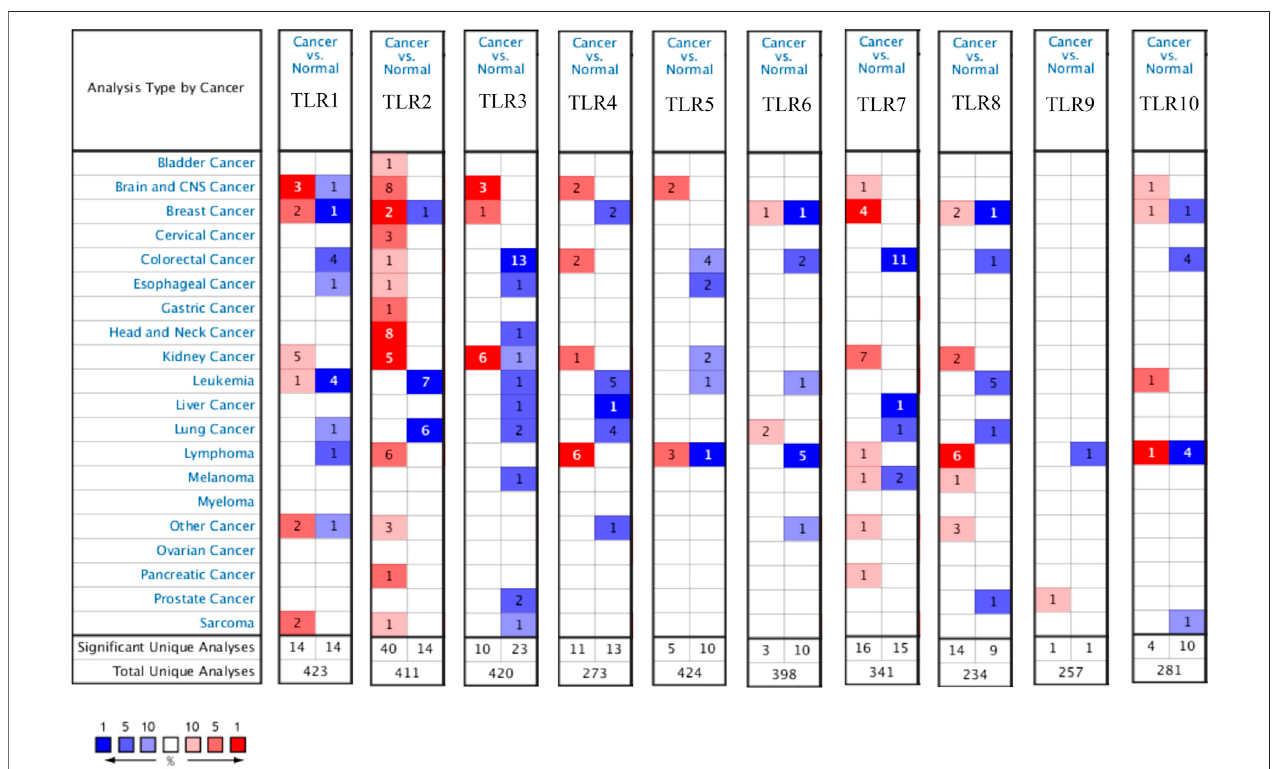
FIGURE 1 | Expression levels of TLRs in kidney cancer. The fi gure showing expression pro fi les of TLRs in tumor and paired normal tissue samples from the ONCOMINE database.